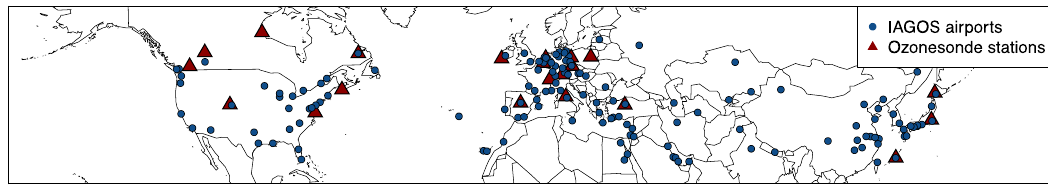
Figure 1. Location of IAGOS airports and WOUDC ozonesonde stations (restricted to 25–60 ◦